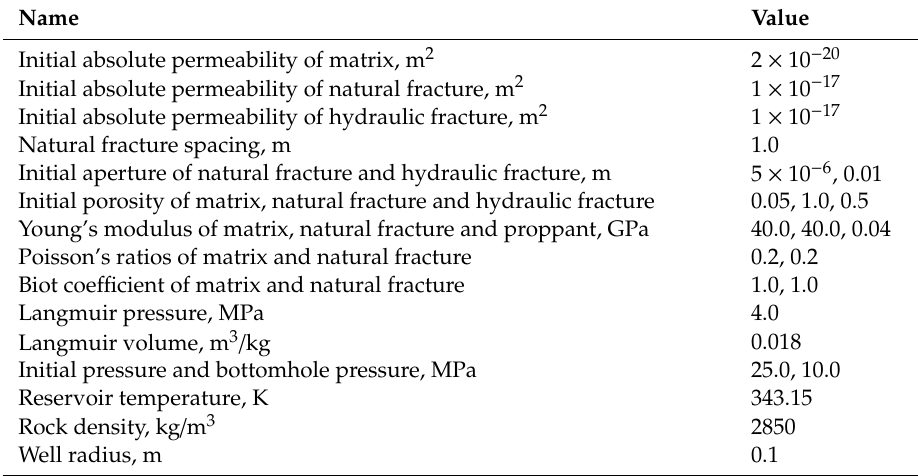
Figure 8. Normalized fracture conductivity under different closure stress, modified from Liu et al. (2018) [14]. Table 1. Parameters of the shale reservoir for model verification.